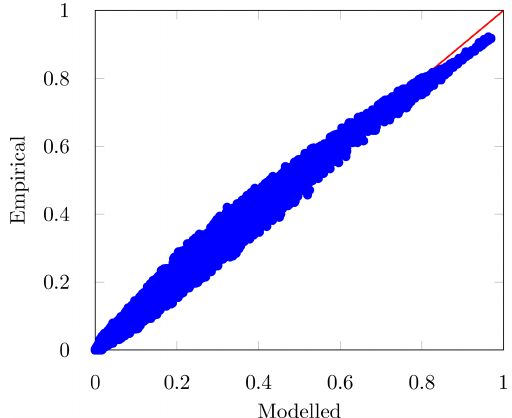
Figure 1. PPVI validation: empirical copula versus bivariate joint probability function. The red line corresponds to the 45 ◦ line. Joint probability values have been computed from Eq. (2), while empiri- cal copula values according to Eq. (5). Table 5. Drought classification according to